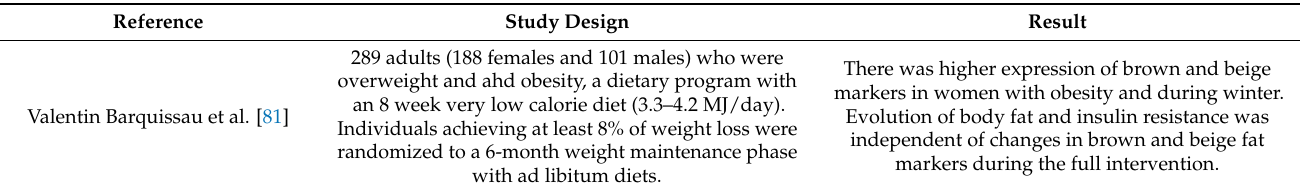
Table 1. Effect of caloric restriction on adipose